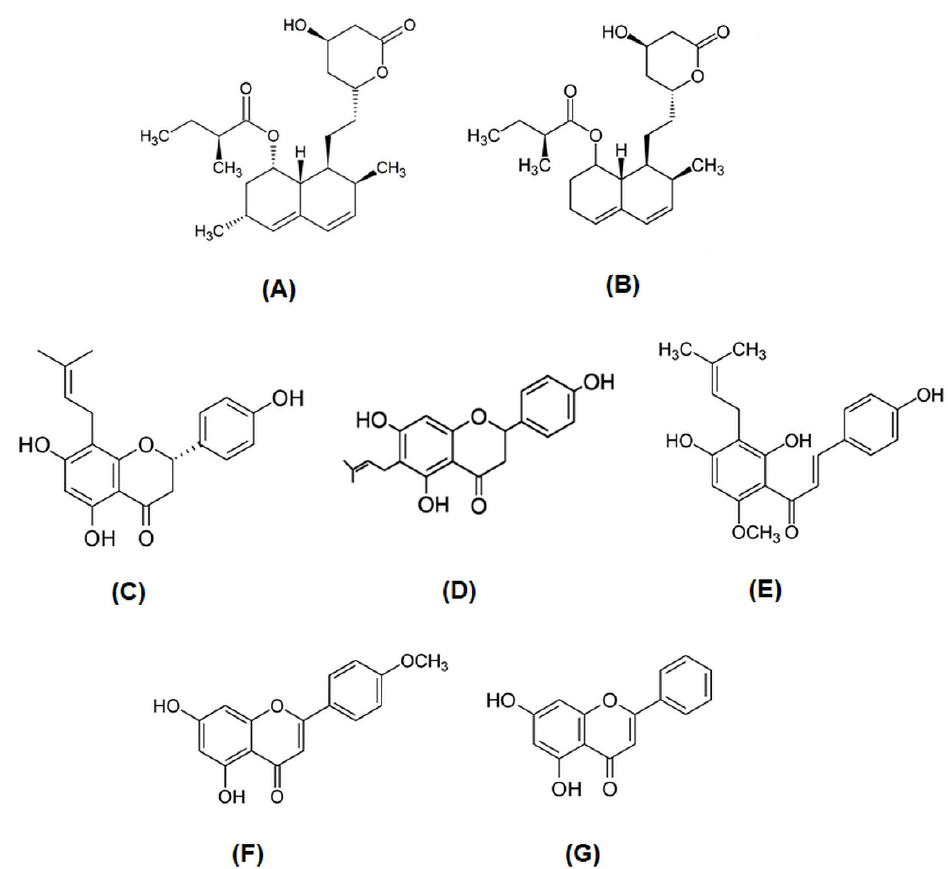
Figure 8. Chemical structures of: simvastatin ( A ), mevastatin ( B ), 8-prenylnaringenin ( C ), 6-prenylnaringenin ( D ), xanthohumol ( E ), acacetin ( F ), and chrysin ( G ).